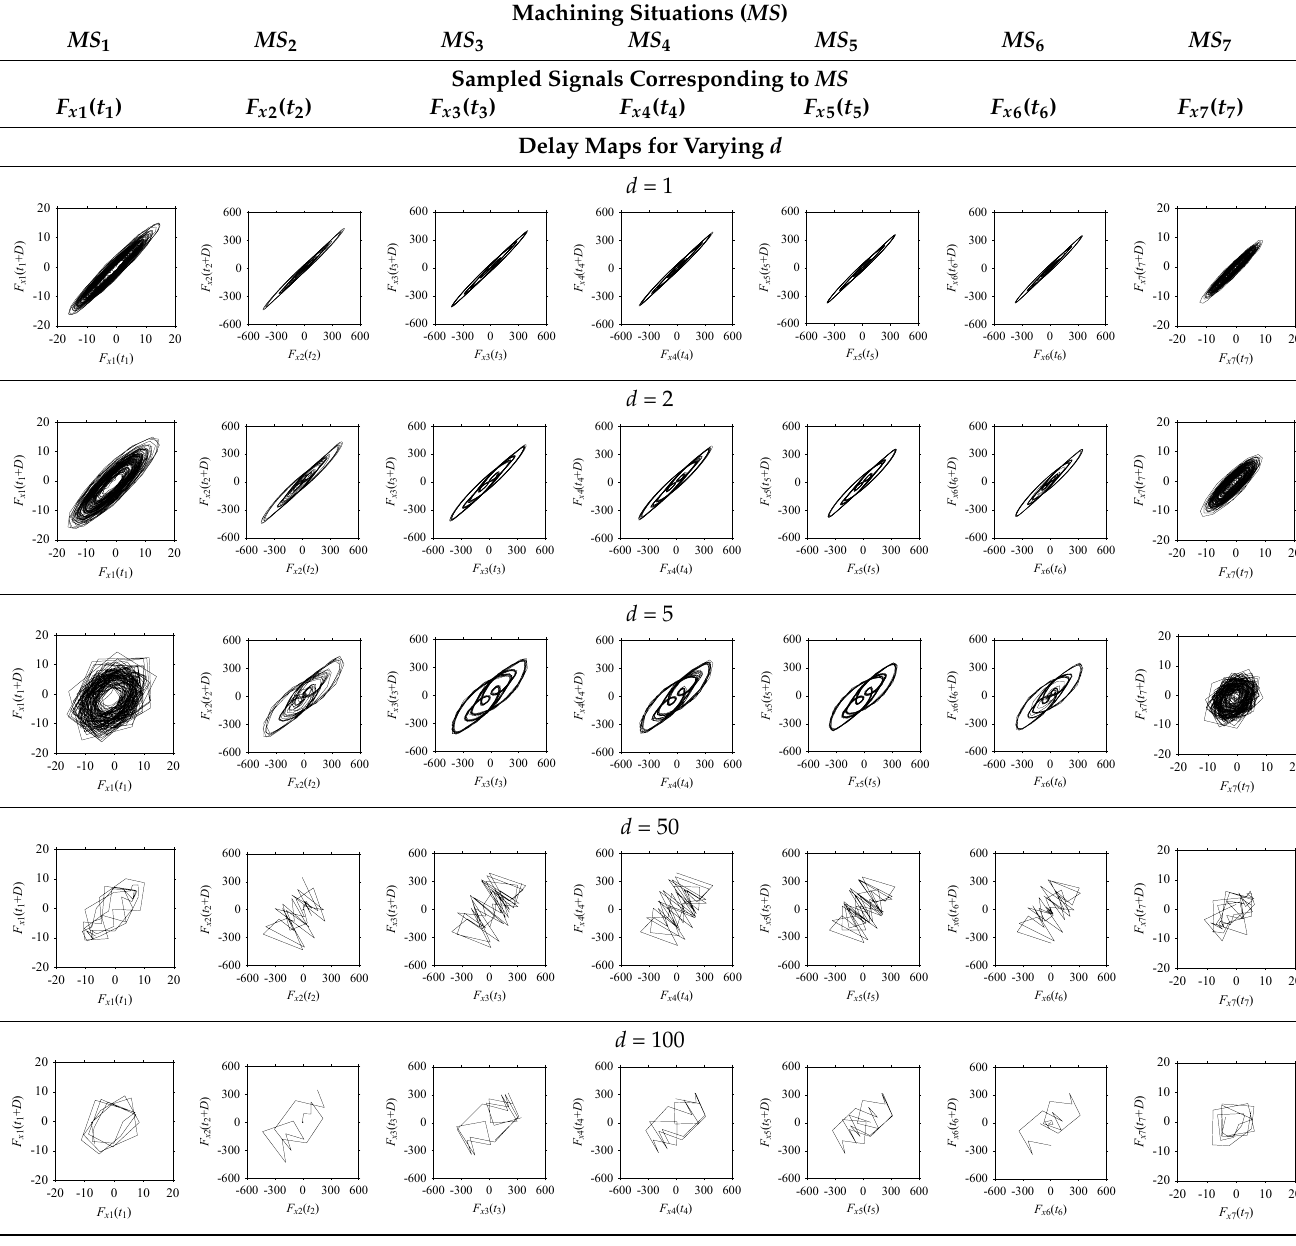
Table 5. Delay maps for F x 1 ( t 1 ),…, F x 7 ( t 7 ) (corresponds to MS 1 ,…, MS 7 ) when d = 1, 2, 5, 50, and 100.